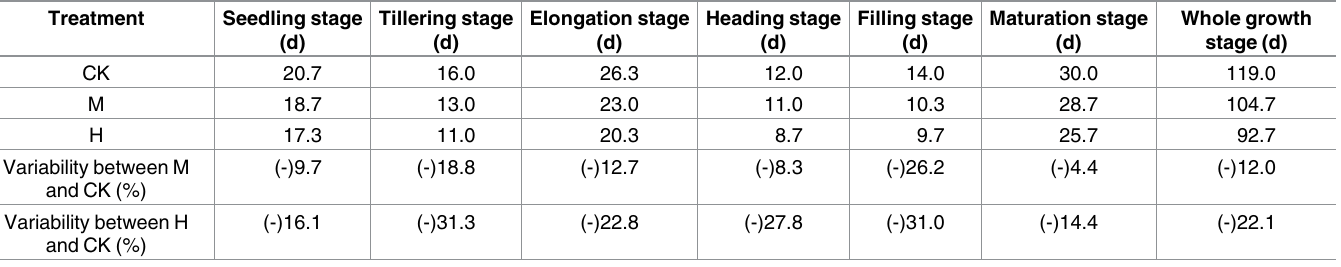
Table 1. Response of rice phenology in different growing periods under different treatmentsof simultaneously increased CO 2 and